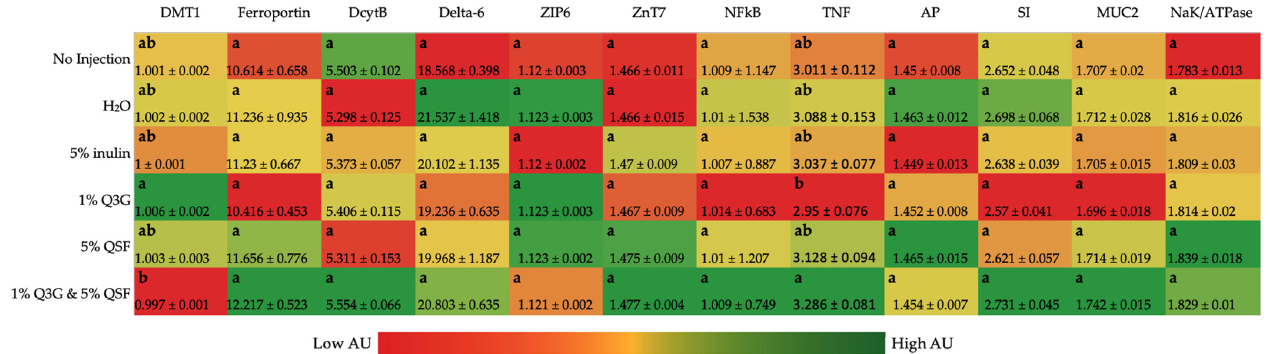
Figure 1. Effect of the intra-amniotic administration of treatments and controls on duodenal gene expression. Values are the means (AU: arbitrary units) ± SEM, n = 6. a,b genes (column wise) not indicated by the same letter are significantly different ( p < 0.05). DMT1, Divalent metal transporter 1; Dcytb, duodenal cytochrome b; ZIP6, Zrt-, Irt-like proteins; ZnT7, zinc transporter 7; NF- κβ , nuclear factor kappa B; TNF- α , tumor necrosis factor; AP, Aminopeptidase; SI, Sucrose isomaltase; MUC2, mucin 2; Q3G, quercetin 3-glucoside; QSF, quinoa soluble fiber.